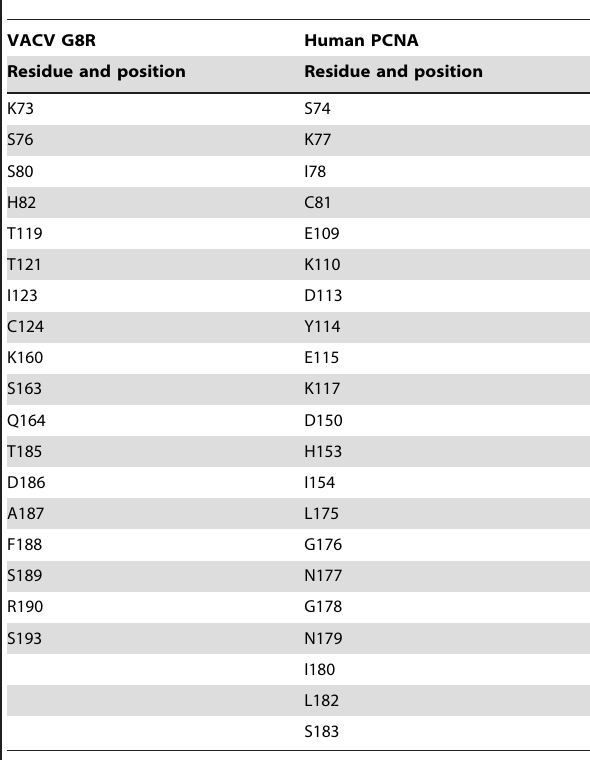
Table 1. Residues and positions of the amino acids in both VACV G8R and human PCNA that are predicted to play a role in trimer